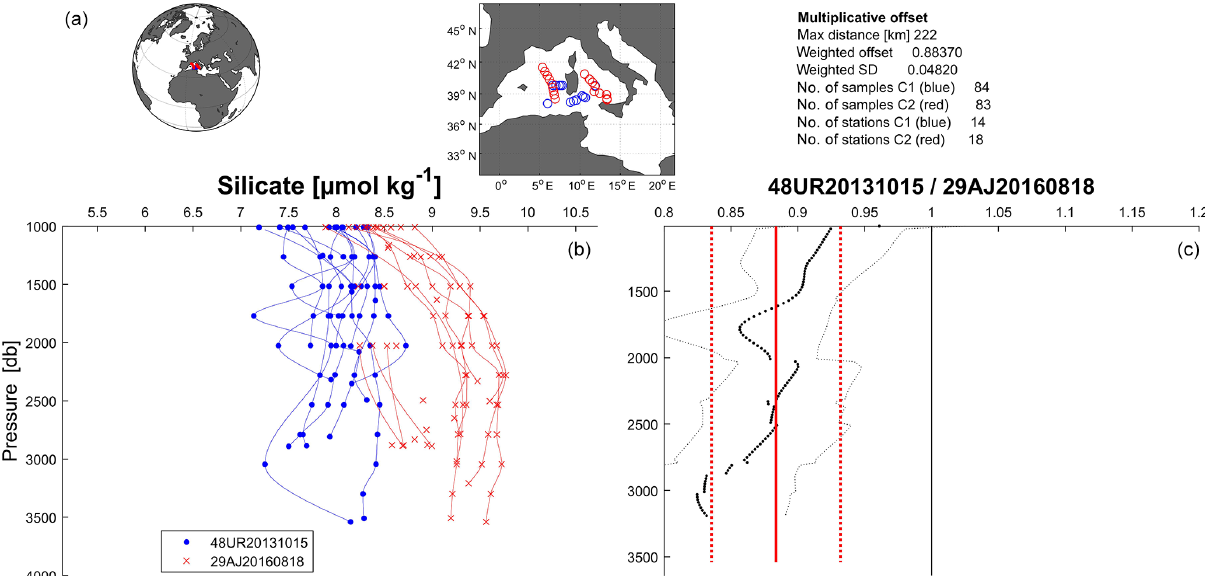
Figure 4. An example of the calculated offset for silicate between cruise 48UR20131015 and cruise 29AJ2016818 (reference cruise). (a) Location of the stations that are part of the crossover and statistics. (b) Vertical profiles of silicate data (µmolkg − 1 ) of the two cruises that fall within the minimum distance criteria (the crossing region), below 1000dbar. (c) Vertical plot of the difference between both cruises (thick dotted black line) with standard deviations (thin dotted black lines) and the weighted average of the offset (solid red line) with the weighted standard deviations (dotted red lines).